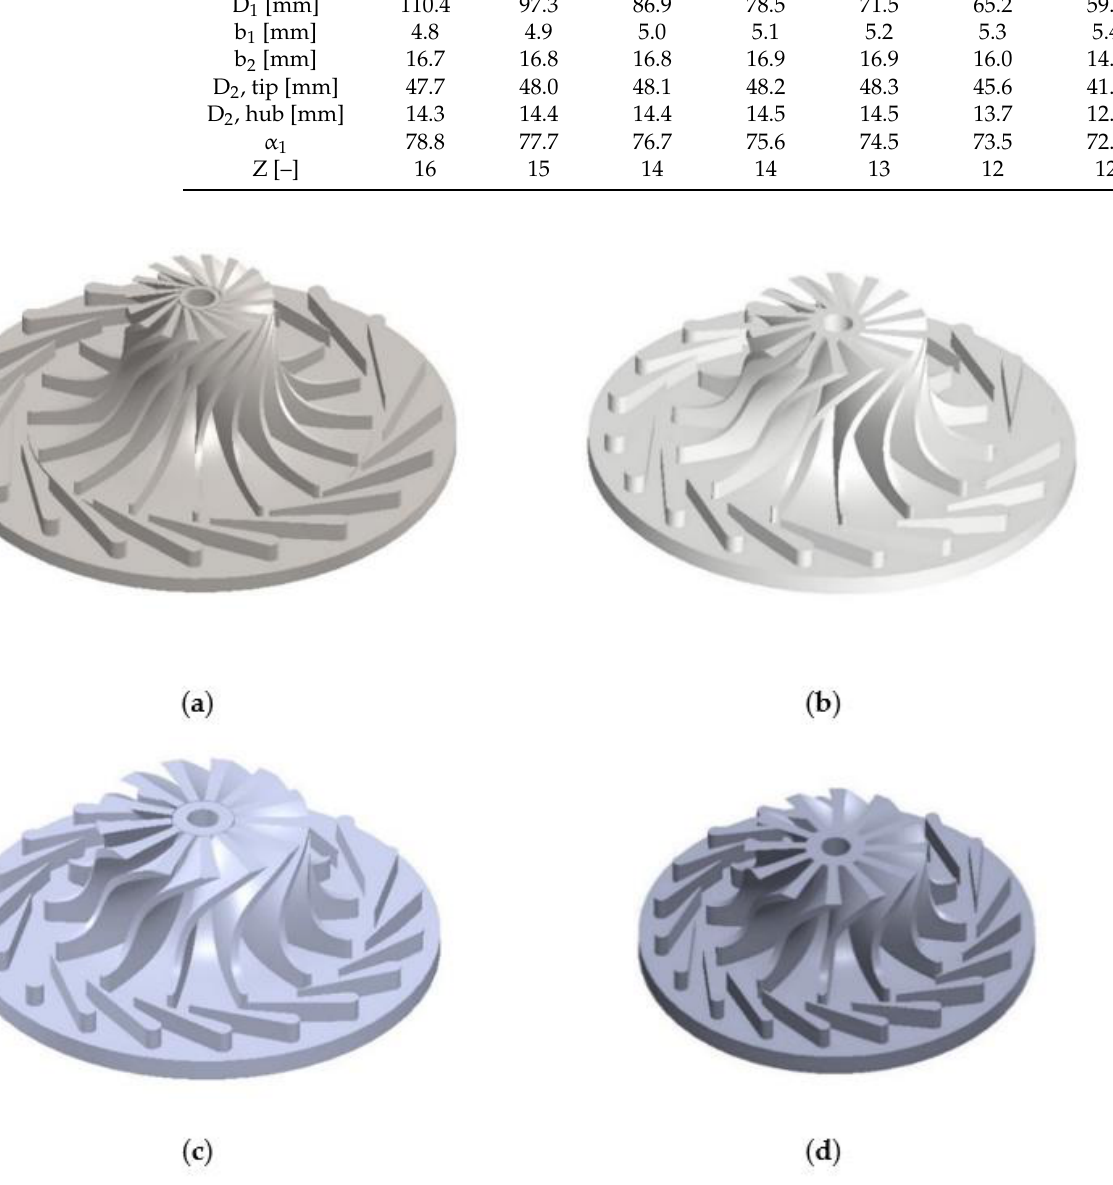
Figure 2. Turbine geometries with different specific speeds, ( a ) Ns = 0.35, ( b ) Ns = 0.45, ( c ) Ns = 0.55 and ( d ) Ns = 0.65.